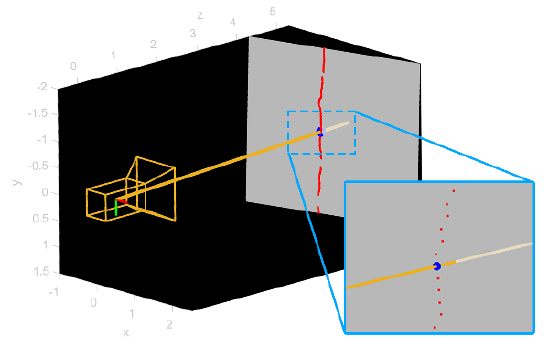
Figure 6 . Schematic view of the ray-plane intersection